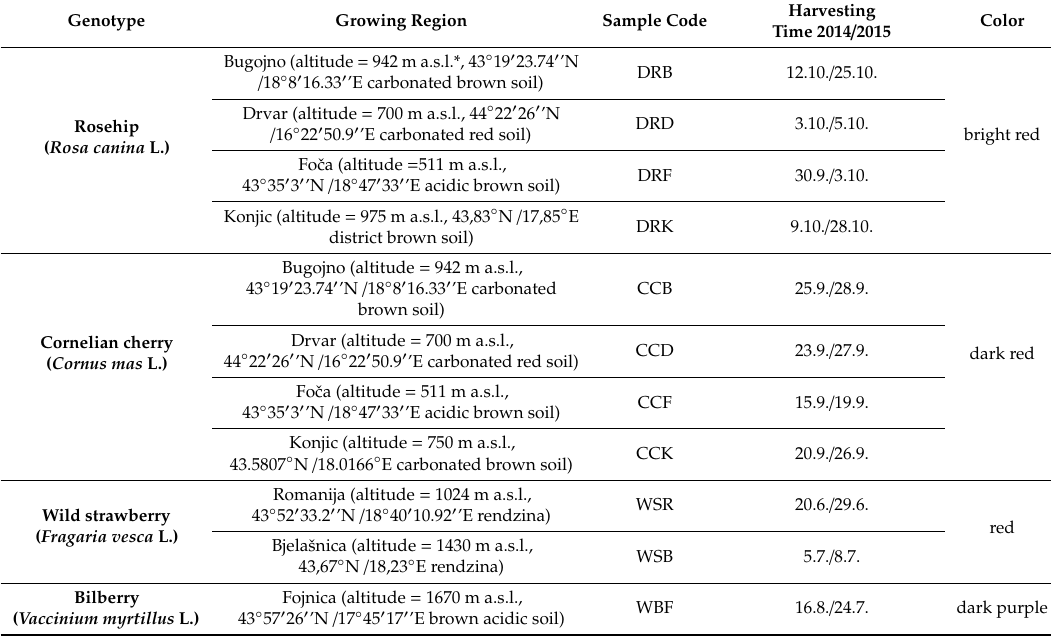
Harvesting Color Time 2014 / 2015